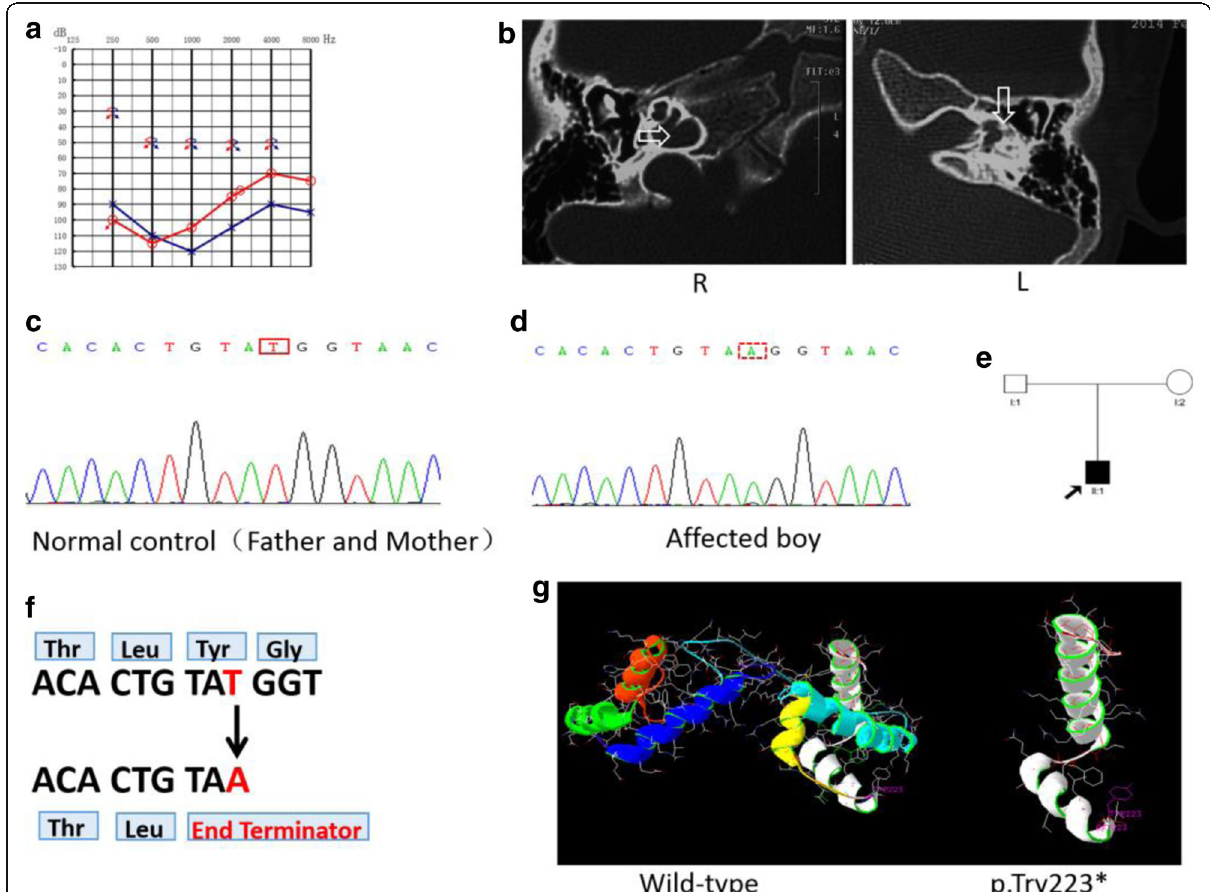
Fig. 3 Pedigree, clinical phenotypes and mutation analysis in family ZSJ. a Audiograms of both ears from the proband exhibited profound sensorineural hearing impairment; b Temporal bone CT images of the proband demonstrating dilation of the lateral end of the IAM and a deficit in the basal turn of the cochlea in the right ear (arrow) in addition to dilation of the lateral end of the IAM and an incompletely developed cochlea in the left ear (arrow); c Wild-type sequence of POU3F4 , including site 669; d A hemizygotic c.669 T>A mutation was detected in the affected boy; e Pedigree of family ZSJ; f Stop codon caused by changes in the DNA sequence; g Molecular modeling of wild-type and mutant POU3F4 proteins. The c.669 T>A mutant creates a new stop codon and is predicted to result in a truncated protein lacking normal POU3F4 transcription factor function